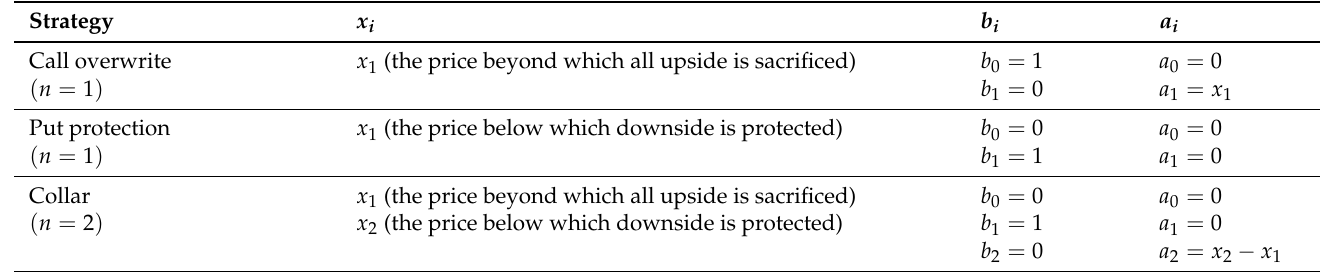
Table 1. Parameters defining three popular option-adjusted